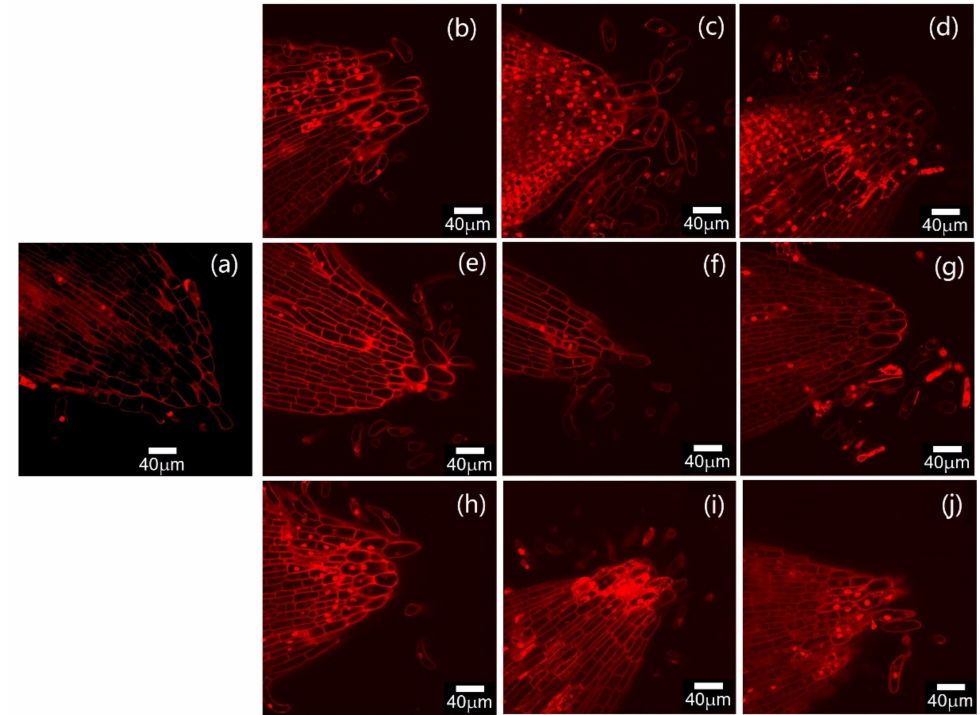
Figure 2. Laser scanning microscopy (LSM) imaging of root tip viability by propidium iodide (PI) staining, where the red fluorescence indicates dead cells. The bar represents a length of 40 µ